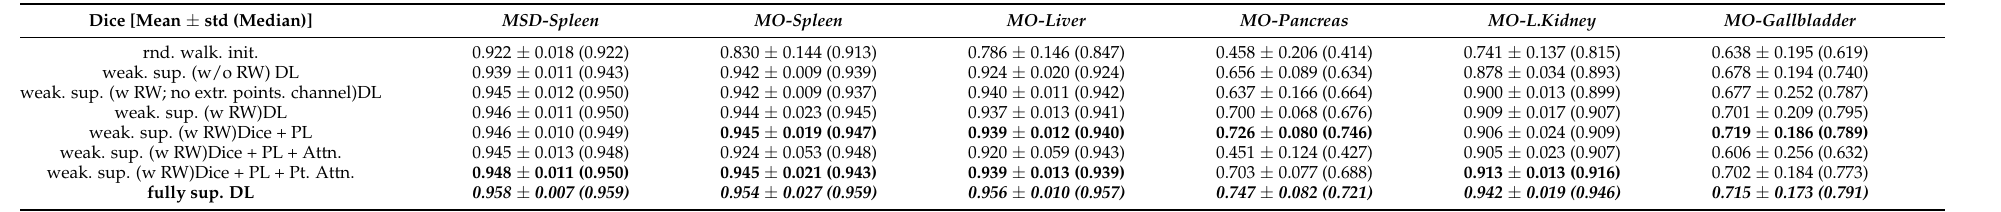
Table 1. Summary of our weakly supervised segmentation results on validation data. This table compares the random walker initialization ( rnd. walk. init. ) with the weakly supervised training approach using Dice loss (DL) ( weak. sup. dextr3D (w/o RW) DL ), without the extra point channel information as input to the network ( weak. sup. dextr3D (w RW; no extr. points. channel) DL ), when using the point channel as input ( weak. sup. dextr3D (w RW) DL ), using the proposed point loss (PL) together with DL ( weak. sup. dextr3D (w RW) Dice + PL ), integrating the attention mechanism as in Oktay et al. [37] ( weak. sup. dextr3D (w RW) Dice + PL + Attn. ), attention with point channel information at attention gates ( weak. sup. dextr3D (w RW) Dice + PL + Pt. Attn. ), and fully sup. ( dextr3D DL ) for reference on different datasets. Dice [Mean ± std (Median)] MSD-Spleen MO-Spleen MO-Liver MO-Pancreas MO-L.Kidney MO-Gallbladder rnd. walk.